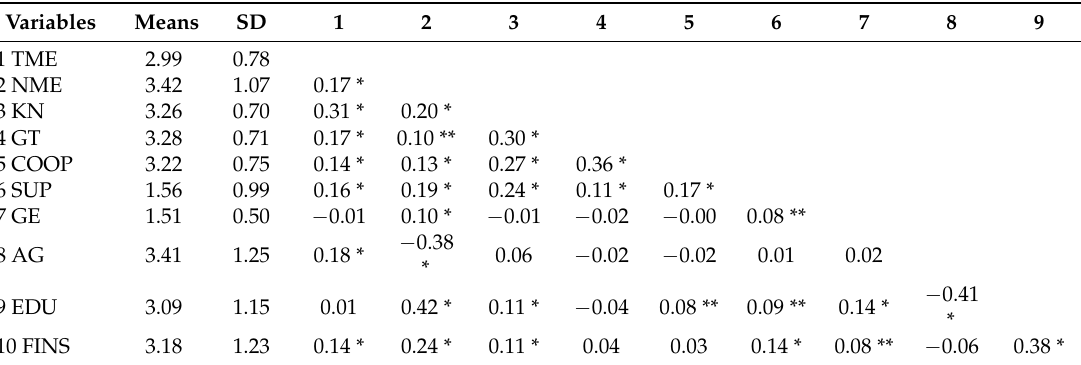
Table 3. Means, standard deviations, and correlation